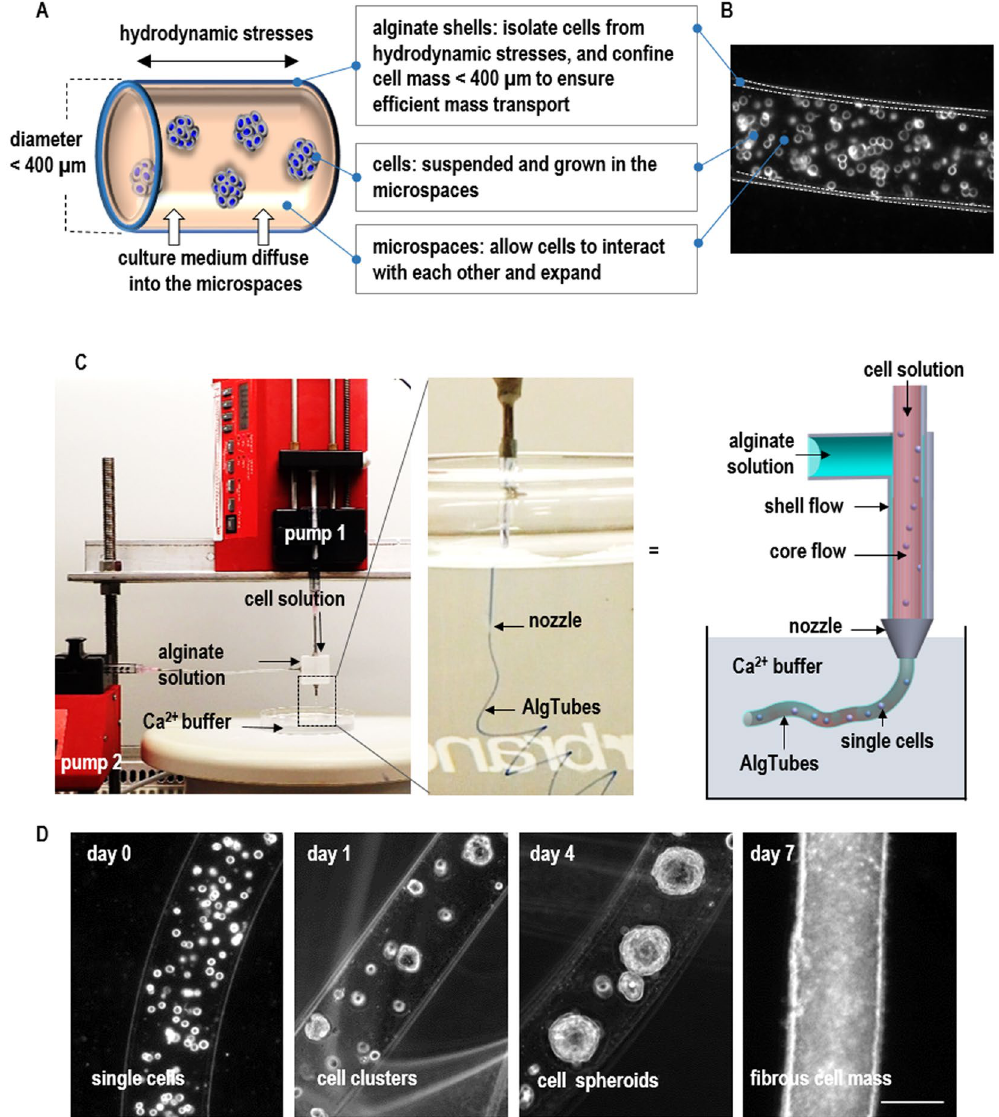
Figure 1. Culturing glioblastoma tumor-Initiating cells (TICs) in alginate hydrogel tubes (AlgTubes). ( A , B ) Glioblastoma TICs were suspended and cultured in microscale alginate hydrogel tubes that were suspended in the cell culture medium in a culture vessel. The tubes protected cells from hydrodynamic stresses in the culture vessel and confined the cell mass less than 400 µ m (in radial diameter) to ensure efficient mass transport. They also provided microspaces for cells to interact with each other and expand. Cell culture medium could efficiently diffuse through the alginate hydrogel shell. An illustration ( A ) and microscope picture ( B ) of an AlgTube. ( C ) To process AlgTubes, a cell and an alginate solution was pumped into the central channel and side channel of a micro-extruder, respectively, to form coaxial core-shell flows that were extruded through the nozzle of the micro-extruder into a CaCl 2 buffer. The shell alginate flow was instantly crosslinked by the Ca 2 + ions to form an alginate hydrogel tube. ( D ) In AlgTubes, individual cells first associated to form small cell clusters. Subsequently, cells proliferated and the small cell clusters expanded to form fibrous cell mass. Scale bar: 200 µ